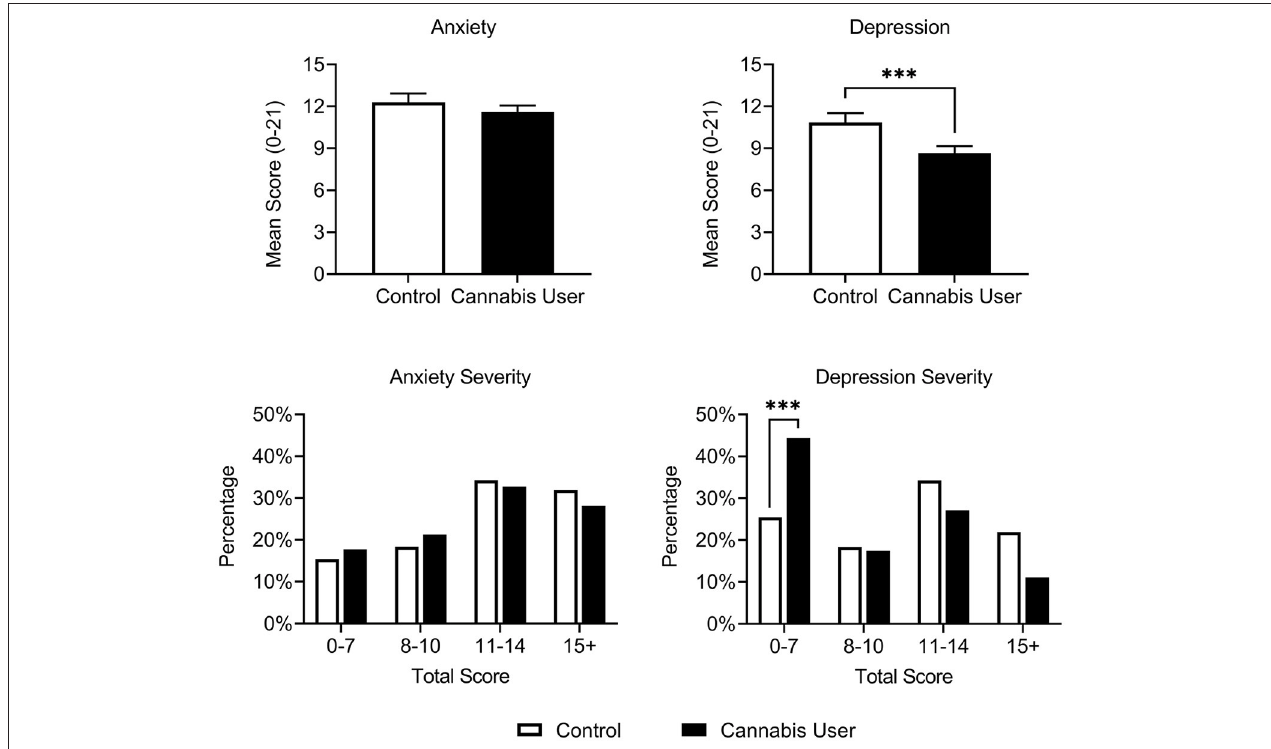
FIGURE 1 | Cannabis Users ( n = 368) had reduced depression, but not anxiety, relative to Controls ( n = 170) on the HADS at baseline. A greater proportion of Cannabis Users also scored below the HADS cutoff for clinical concern (scores ≥ 8) relative to Controls. Scores ranging from 8 to 10, 11 to 14, and 15 to 21 represent approximate cutoffs for mild, moderate, and severe cases, respectively ( 83). *** p < 0.001.